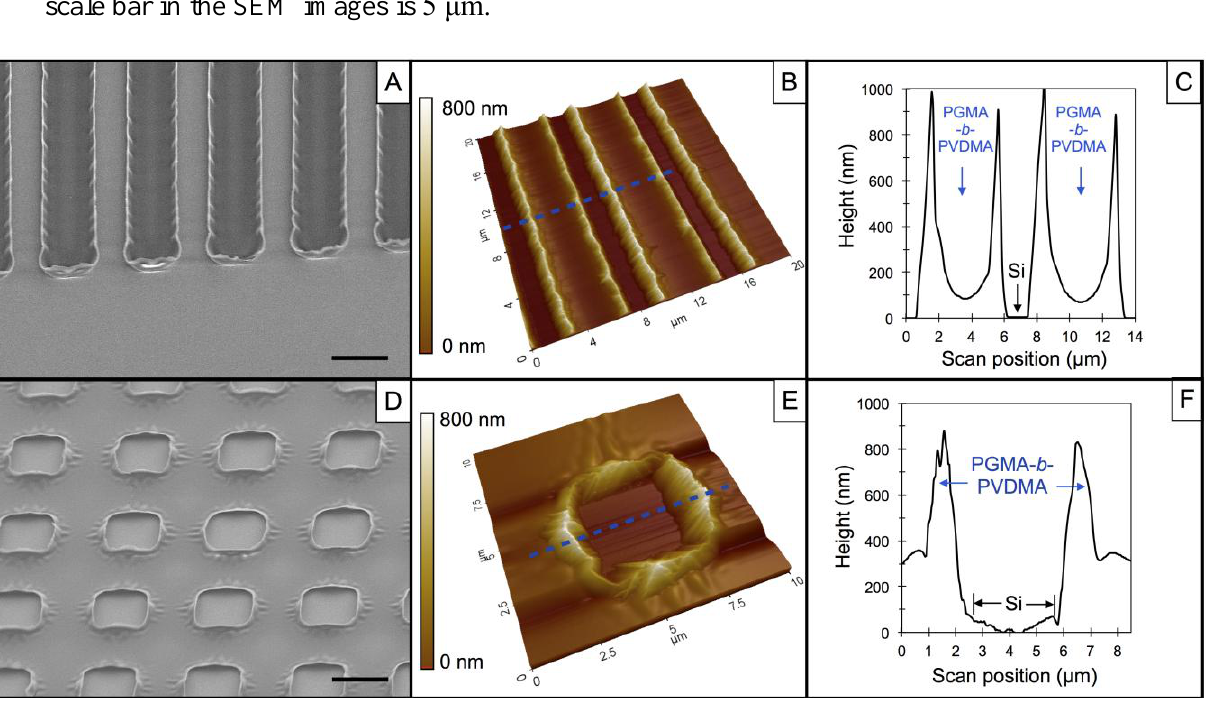
Figure 1. Characterization of PGMA- b -PVDMA patterned films. ( A ) Scanning Electron Microscopy (SEM) and ( B ) Atomic Force Microscopy (AFM) contact mode image of films patterned as 5 µm wide line arrays with a 7 µm pitch. ( C ) Cross-sectional height profile of blue line in ( B ). ( D ) SEM image and ( E ) AFM contact mode image of films patterned as square grids with a 10 µm pitch. ( F ) Cross-sectional height profile of blue line in ( E ). The scale bar in the SEM images is 5